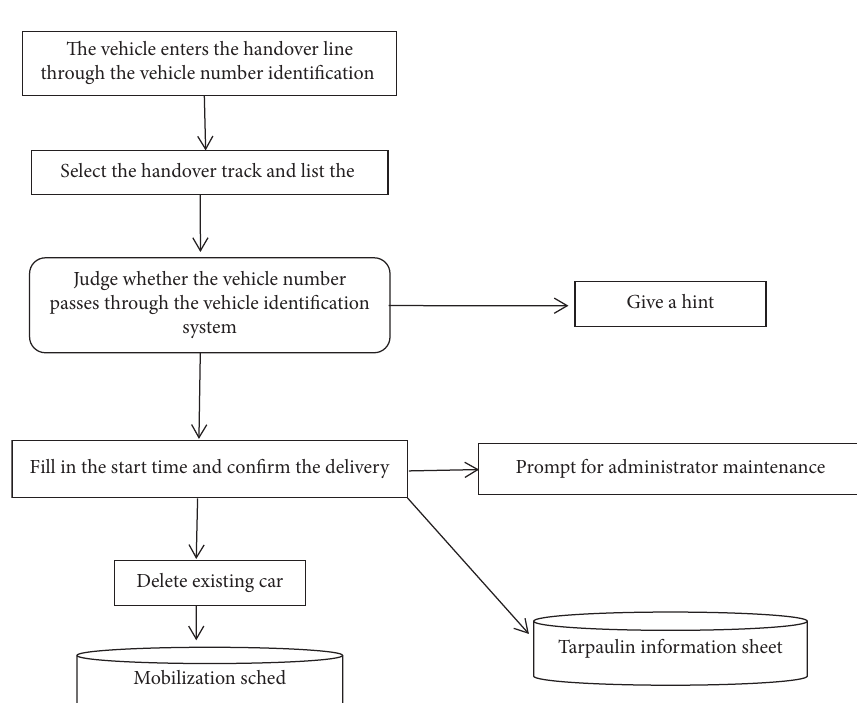
Figure 5: Loading process flowchart.